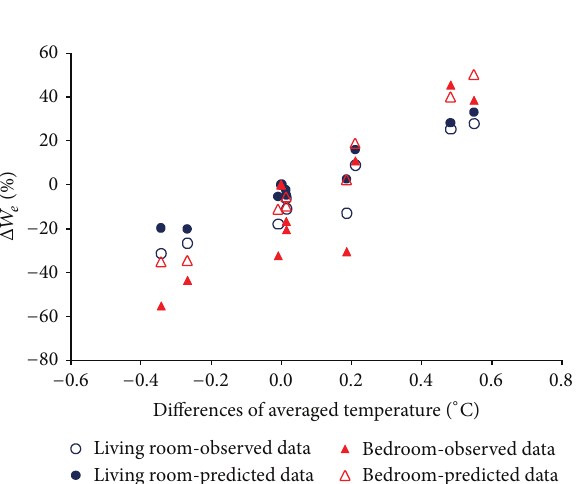
Figure 9: The percentage of Δ𝐻 𝑒 versus difference of averaged temperature during investigated period.